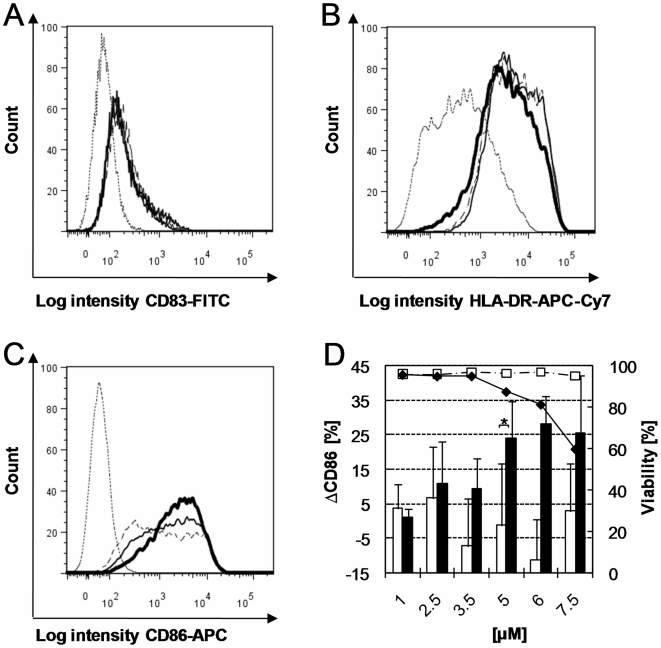
Expression of CD83, HLA-DR, CD86 and viability of PBMDCs exposed to CPZ and UVA radiation.Histogram overlays show CD83 (A), HLA-DR (B) and CD86 expression (C) measured by flow cytometry on irradiated (1 J/cm2 with 3.4 mW/cm2) PBMDCs. In each histogram the dotted line and thin dashed line indicate the results obtained with the isotype control or untreated control respectively. The results obtained with PBMDCs exposed to CPZ are indicated by a solid line (2.5 µM) or a heavy solid line (5 µM). D: ΔCD86 measured on PBMDCs exposed to the indicated CPZ concentrations (X axis) with (black columns) or without (open columns) UVA radiation (1 J/cm2 with 3.4 mW/cm2). The viability (right Y axis) of non-irradiated (open squares, dashed line) and irradiated cells (black diamonds, solid line) is also indicated. Mean values for cell viability and mean ± standard deviation for ΔCD86 expression of at least 5 independent donors are shown. Negative ΔCD86 values were due to biological variability. Asterisk indicates significant difference between irradiated and non-irradiated ΔCD86 values (p<0.05, Wilcoxon test).